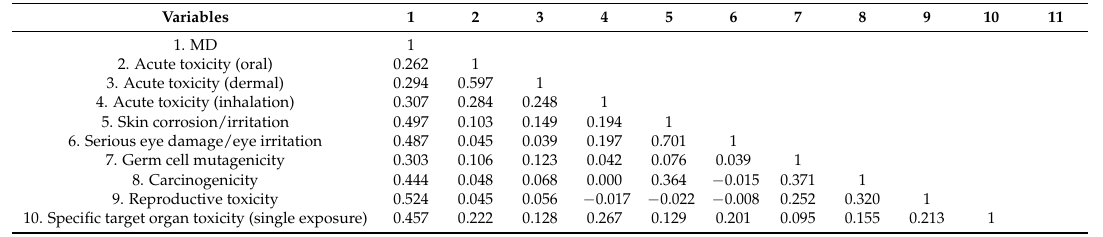
Table 4. The results of the correlation analysis between the Mahalanobis distances (MDs) of 3028 chemicals and the 10 quantified health hazard